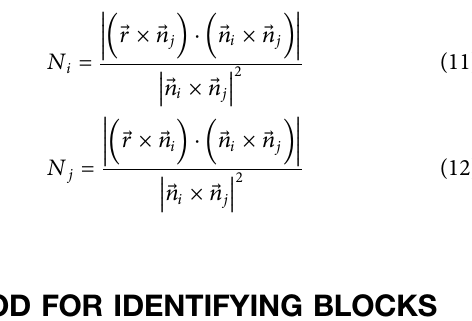
Based on the cutting algorithm, the identi fi cation of the blocks formed by the fi nite discontinuities is realized through the meshing method.